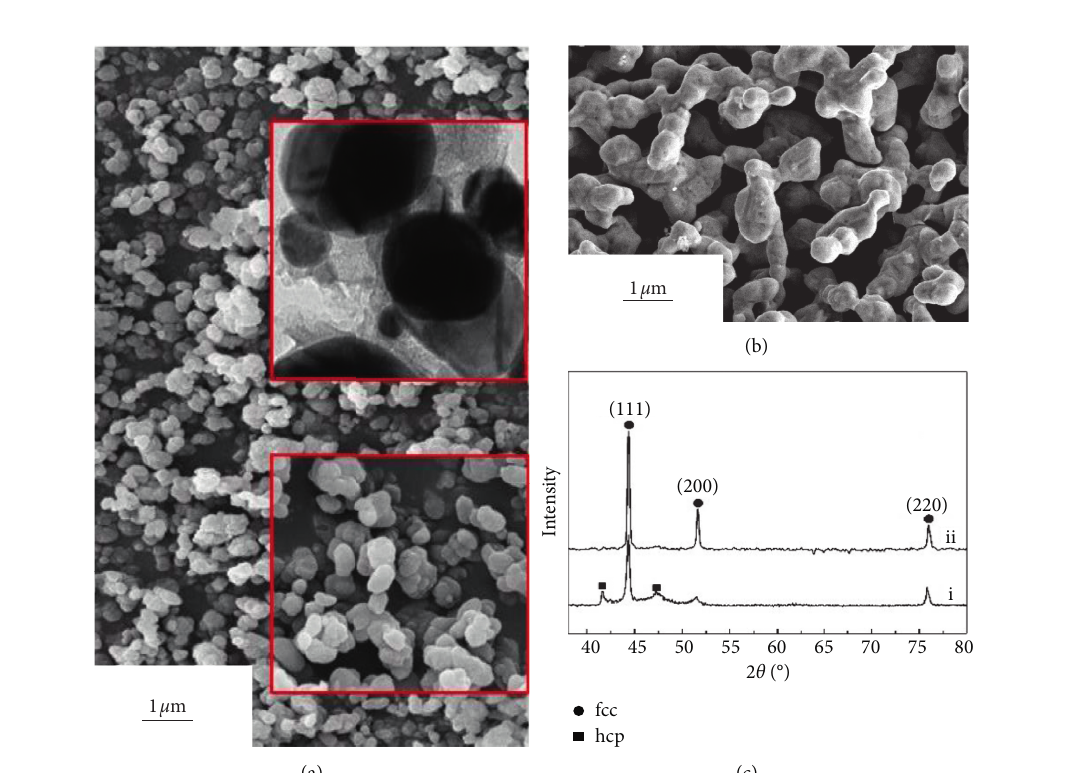
Figure 2: (a, b) The structure and morphology of the cobalt powder as detected by XRD and SEM. (c) Graph of (i) the β -Co powder and (ii) the commercial cobalt powder ( α / β -Co).